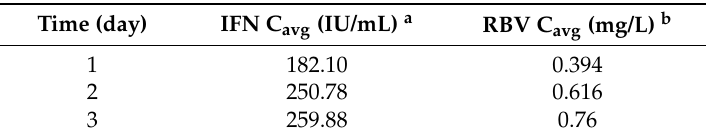
Table 1. Average concentrations (C avg ) calculated based on the human pharmacokinetics (PK) profiles associated with the HCV clinical regimens of 36 million IU twice daily (BID) of interferon- α (IFN) and 600 mg BID of ribavirin